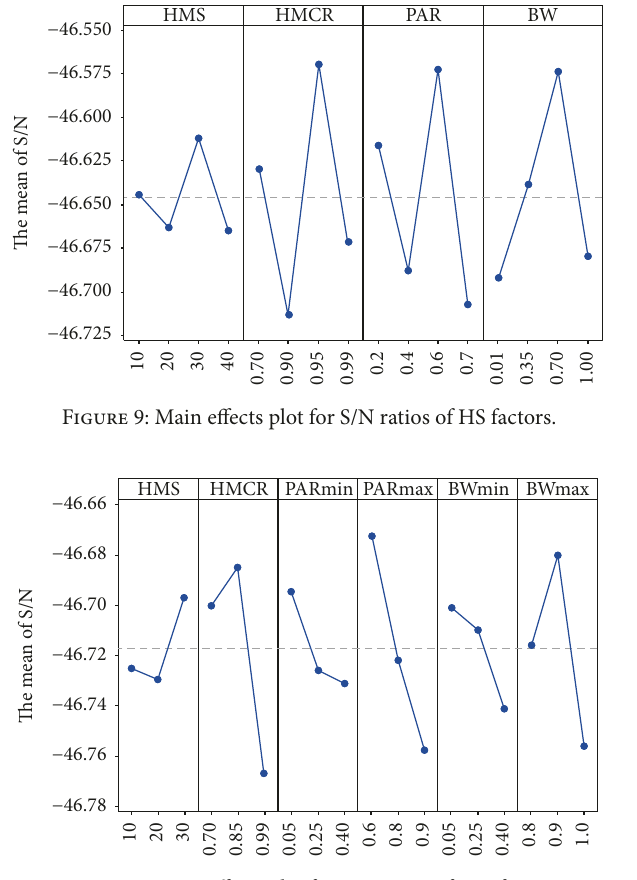
Figure 10: Main effects plot for S/N ratios of IHS factors. Table 2: Levels of parameters for